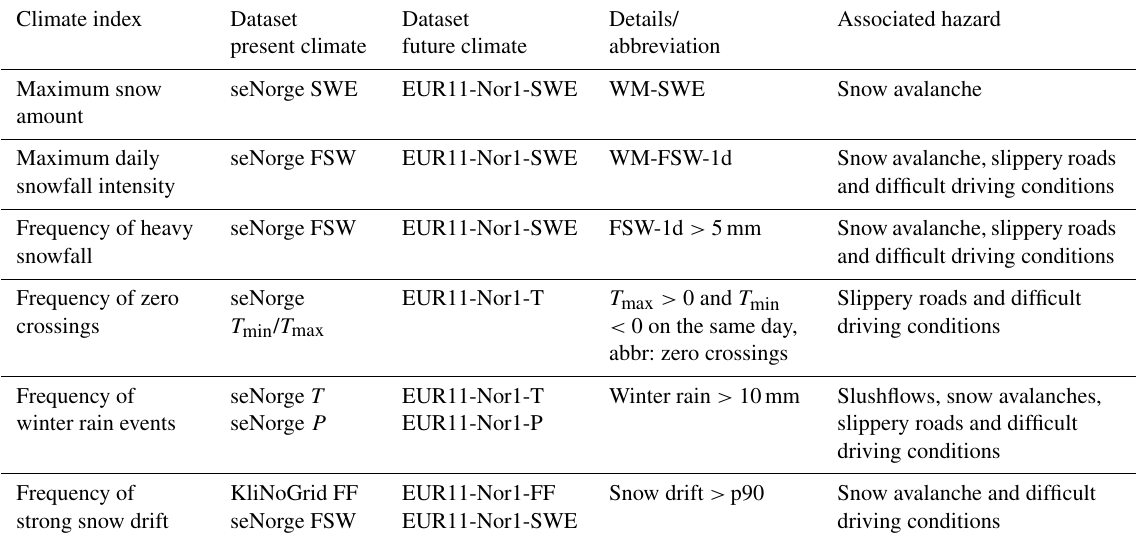
Table 1. Description of selected climate indices. Climate